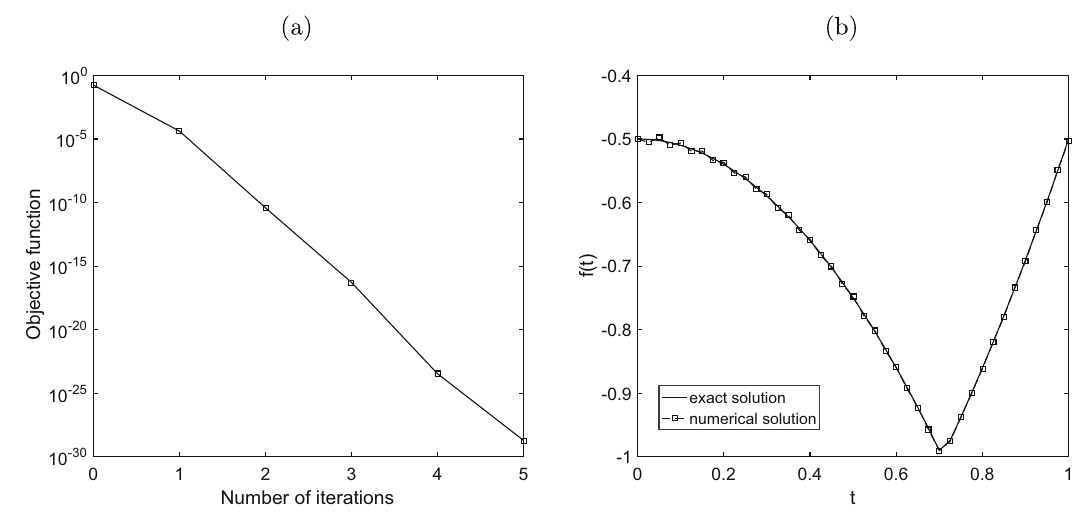
Figure 7: ( a ) J ( 73 ) and ( b ) the exact ( 89 ) and approximate ( ) f t , with = p 0 and without regularzation parameter, for Example 2.